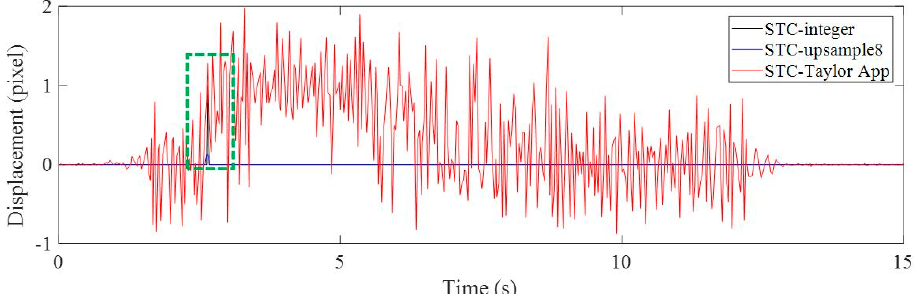
Figure 10. Horizontal displacement time histories of P1 in pixel units using non-subpixel, image upsampling, and Taylor approximation techniques.